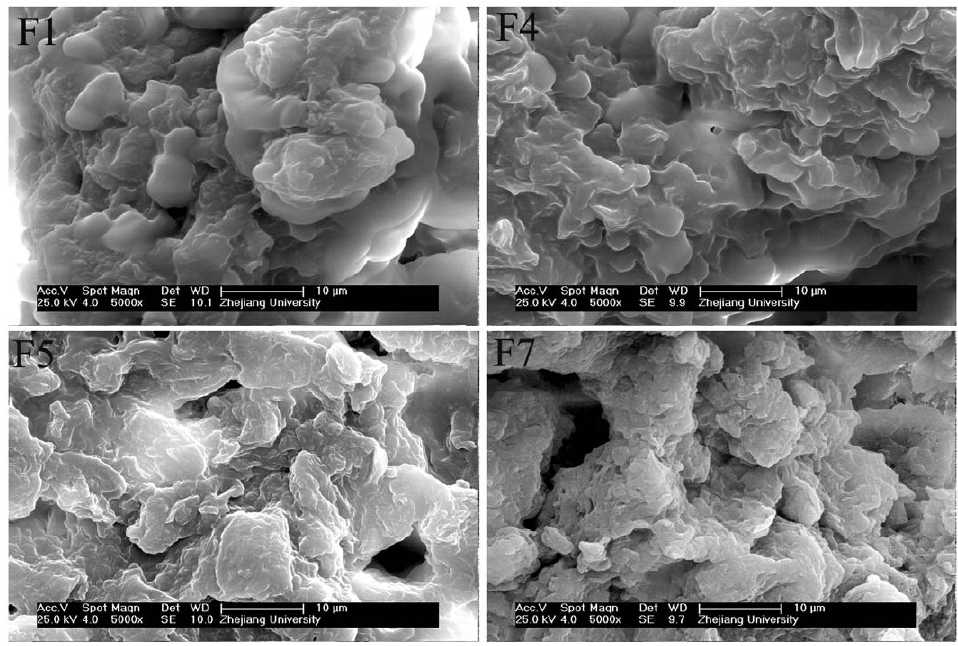
Figure 2. The SEM images of four selected biosorbents.